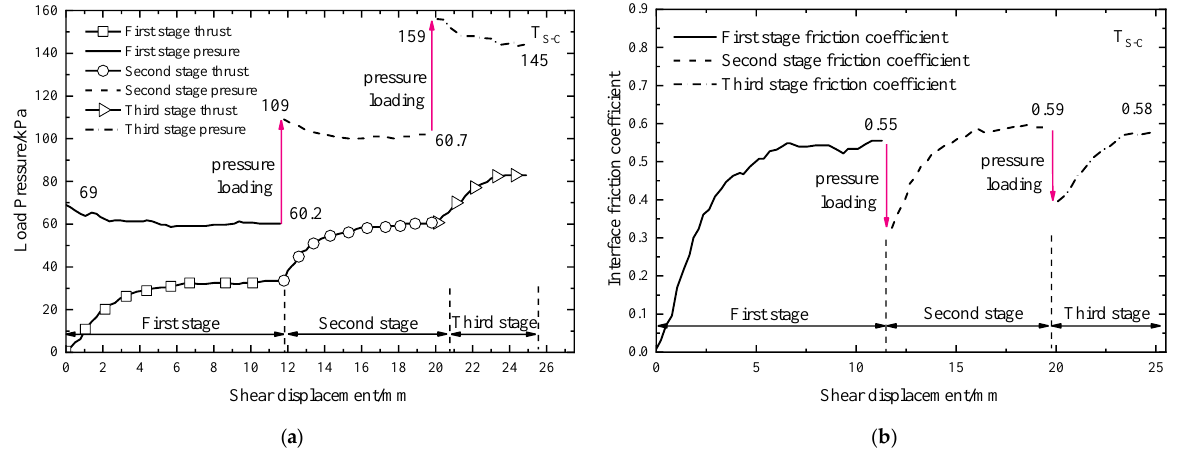
Figure 14. Interface shear test results of the T S-C group: ( a ) Friction coefficient displacement curve of the T C28d group and ( b ) Friction coefficient displacement curve of the T S-C group.